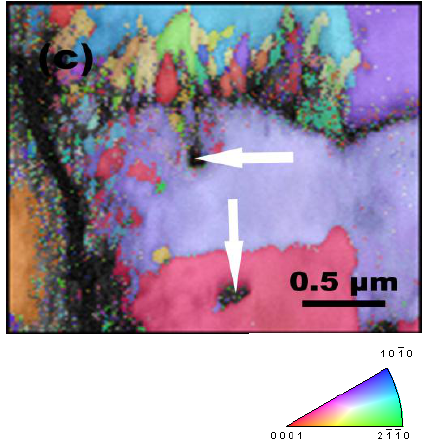
Figure 4. EBSD analysis on the surface of a 20-pulsed WC-Co sample: ( a ) SEI (Secondary electron imaging mode) micrograph; ( b ) corresponding EBSD orientation map; and ( c ) EBSD orientation taken from the selected area. The scanning step was set at 30 nm.